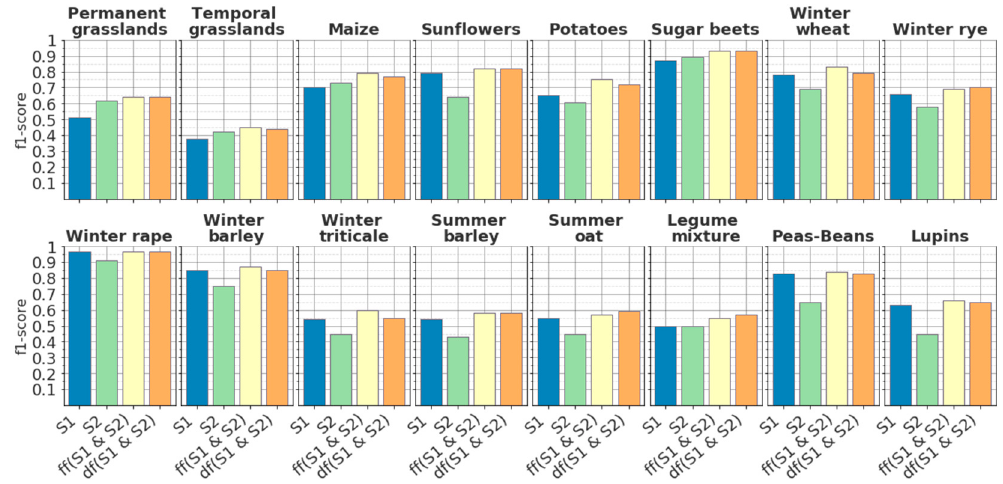
Figure 7. Crop-specific accuracies derived from the classifications based on only SAR ( S1 ), only optical ff (S1&S2) ) and decision fusion ( df(S1&S2) ( S2 ) features, and optical-SAR feature stacks ( ff(S1&S2) ) and decision fusion ( df(S1&S2) ). ( S2 ) features, and optical-SAR feature stacks (